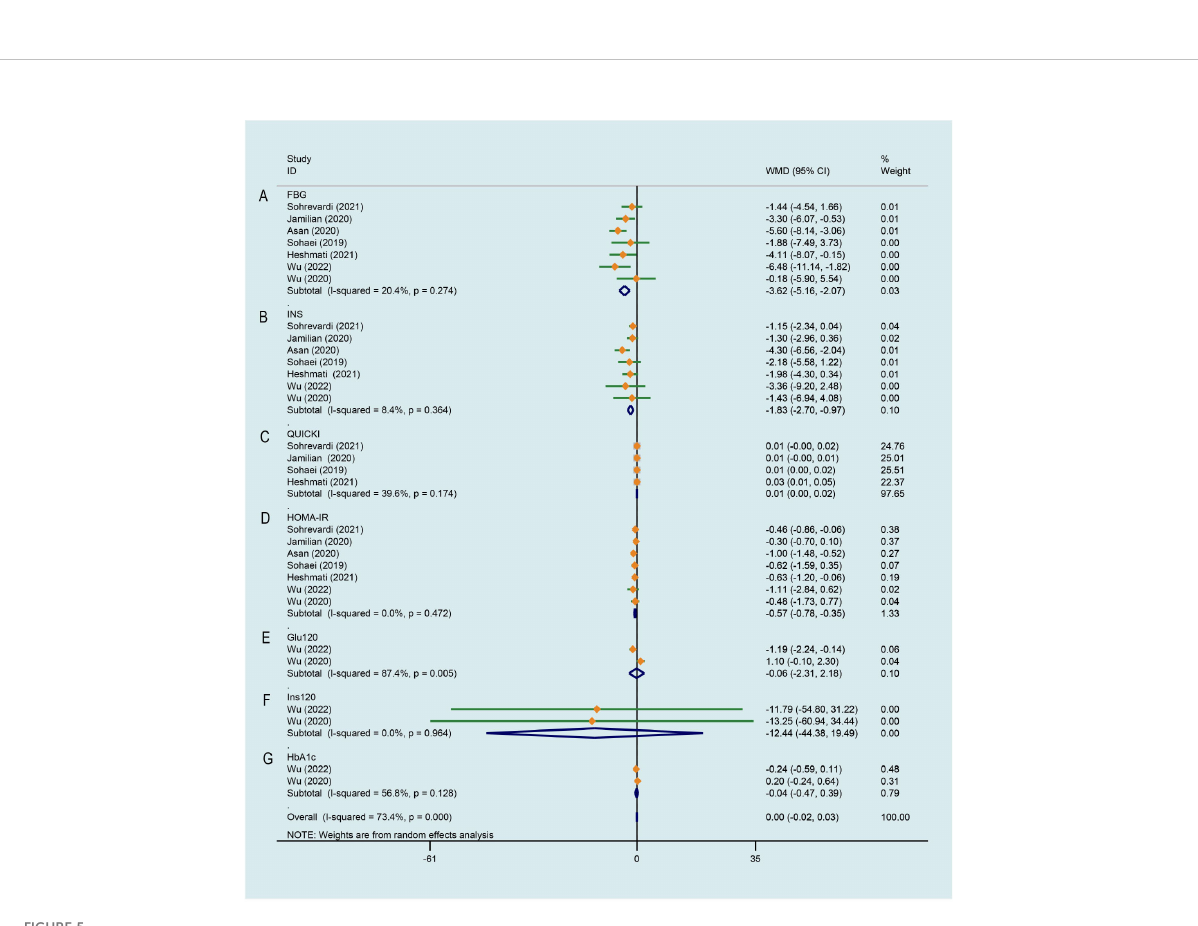
FIGURE 5 Meta-analyses of the effect of curcumin on glucose metabolism. (A) FBG, (B) INS, (C) QUICKI, (D) HOMA-IR, (E) Glu120, (F) Ins120, (G) HbA1c.